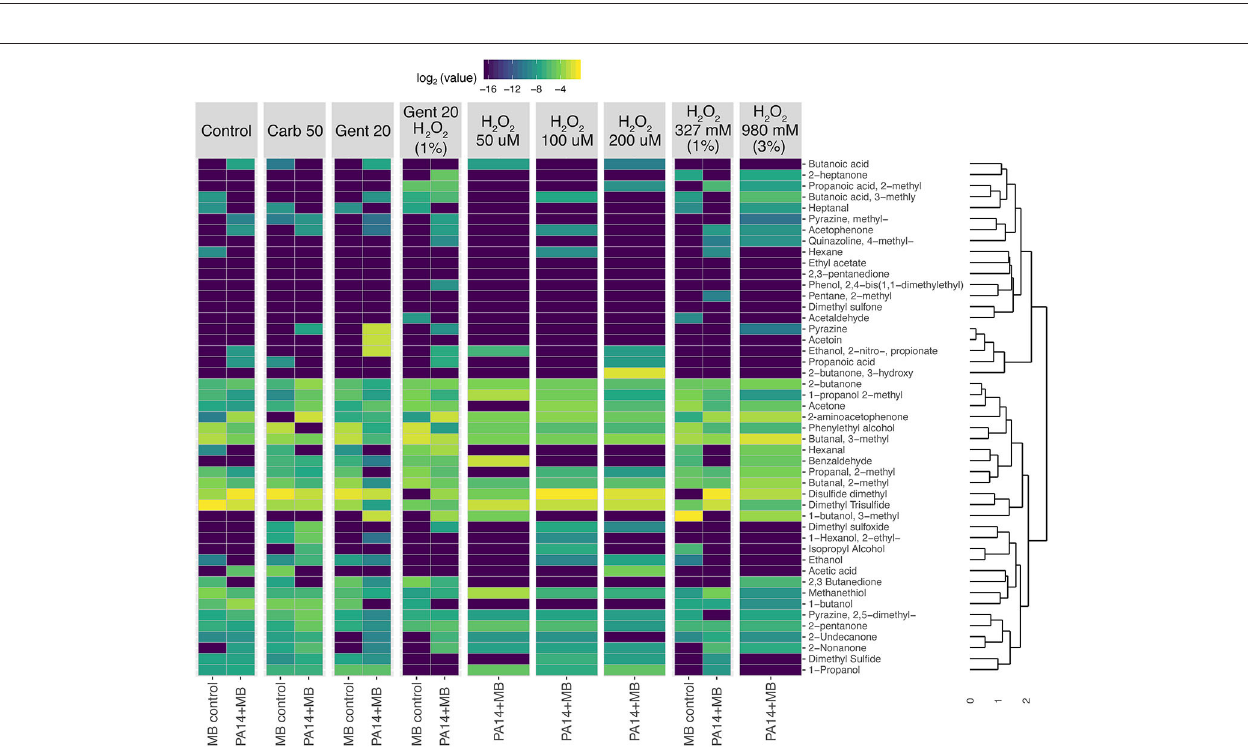
FIGURE 6 | Heatmap showing clustering of relative abundances of volatile metabolites. PA14 + MB represents the microbial community on a meat sample with both PA14 and MB(PA14) populations. The MB control community is a meat sample with only the meat microbial background. Metabolites were first normalized by total sample intensity. A Bray-Curtis distance matrix was generated for clustering with the unweighted pair group method with arithmetic mean (UPGMA)